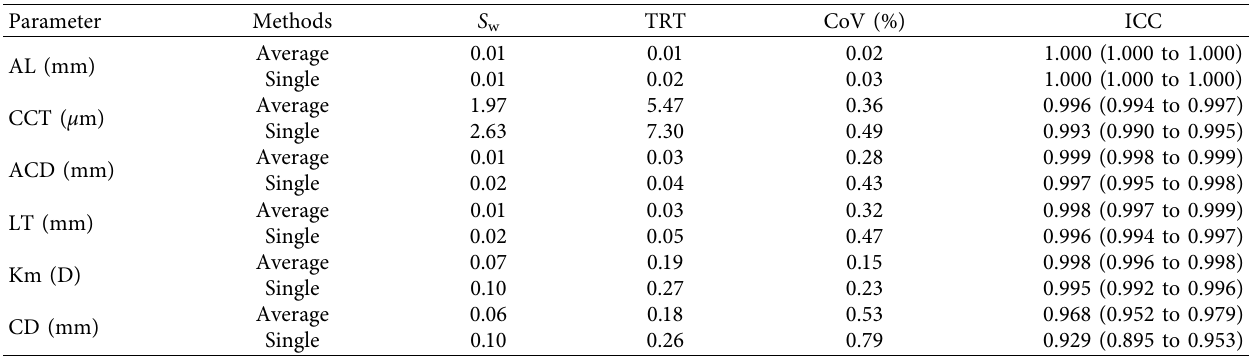
Table 5: Interobserver reproducibility outcomes for biometric measurements obtained using an IOLMaster 700 swept-source optical coherence tomography-based biometer in normal subjects.